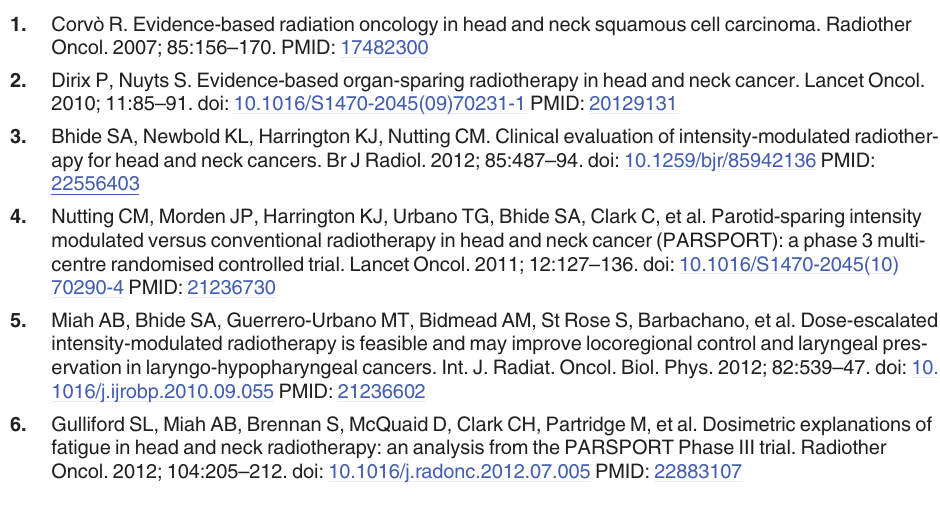
S1 Fig. Illustration of the non-coplanar beam arrangement for a typical BSRT plan, includ- ing anterior superior oblique, and posterior inferior oblique beams. Combinations of gantry angles and couch twists were chosen such that all beams were deliverable, without collision, on Elekta linacs. S2 Fig. Bilateral hippocampal EQD2 D40% data for standard clinical plans (red), HSRT (green), and BSRT (blue) on the NTCP model of NCF after brain RT (as measured by the Wechsler Memory Scale-III Word Lists delayed recall at 18 months post-RT) of Gondi et al., (2013) [13] for the 8 NPT cases. S3 Fig. Illustration of the effect of HSRT on dose to the antero-lateral temporal lobes (left panel, arrows), relative to the standard clinical plan (centre panel). BSRT succeeds in elimi- nating this additional temporal lobe dose as well as further reducing the whole brain dose (right panel, arrows). S1 Table. Clinical dose statistics and objectives for targets, organs at risk (OARs), and plan- ning-at-risk volumes